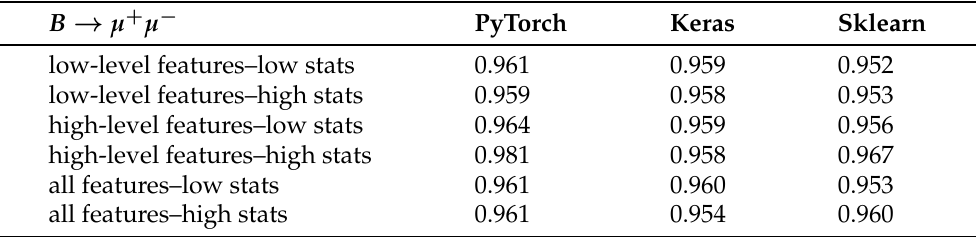
Table 5. B µ + µ − channel: AUC scores for the different classifiers with all the libraries. → B → µ + µ −